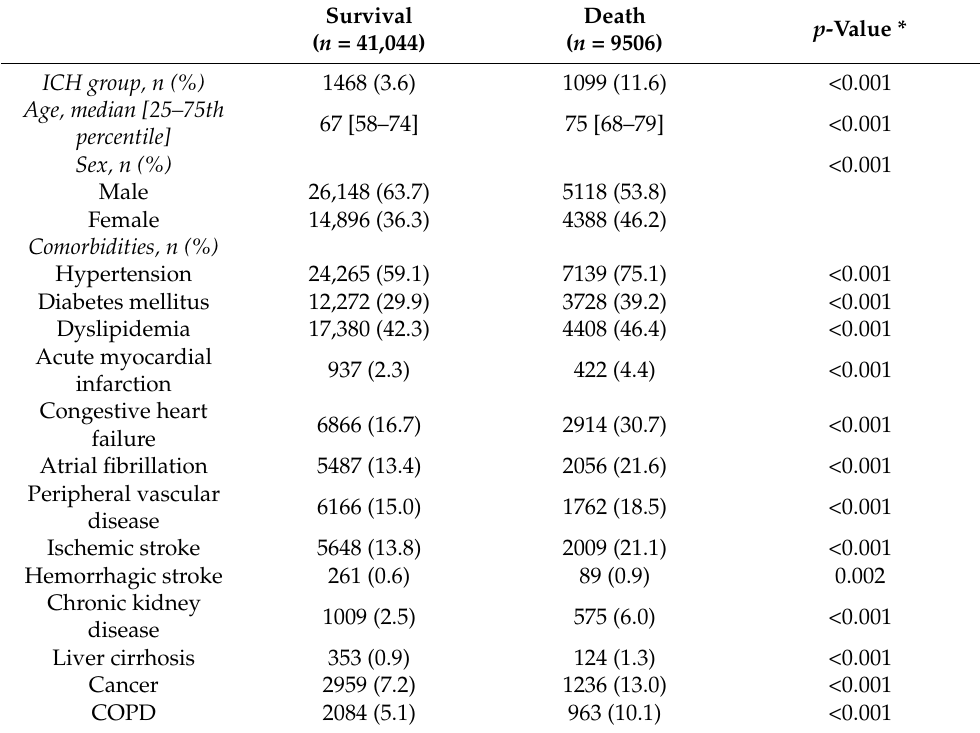
Table 2. Univariable analysis of attributing factors for 12-month mortality.